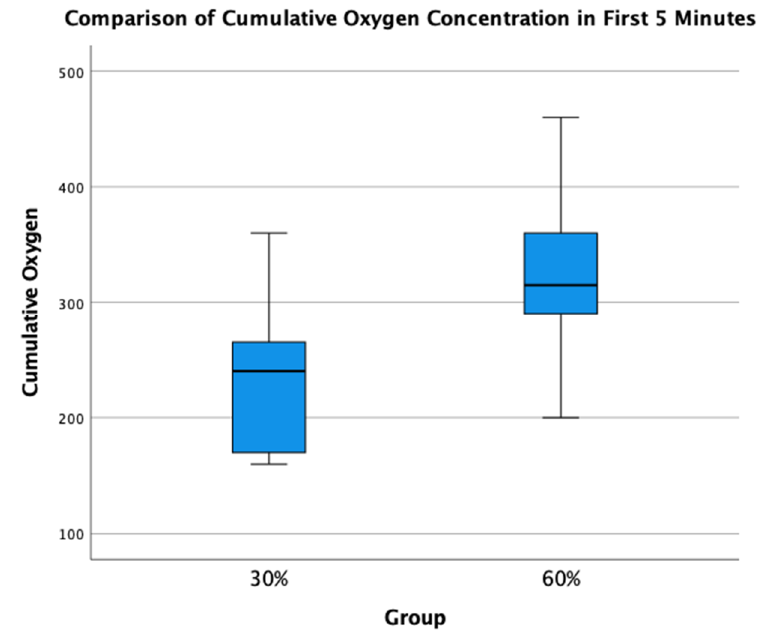
Figure 3. Comparison of Total Supplied Oxygen Concentrations for the first 5 min. In the 30% and 60% O 2 groups, 12 (100%) and 17 (94%) received positive pressure